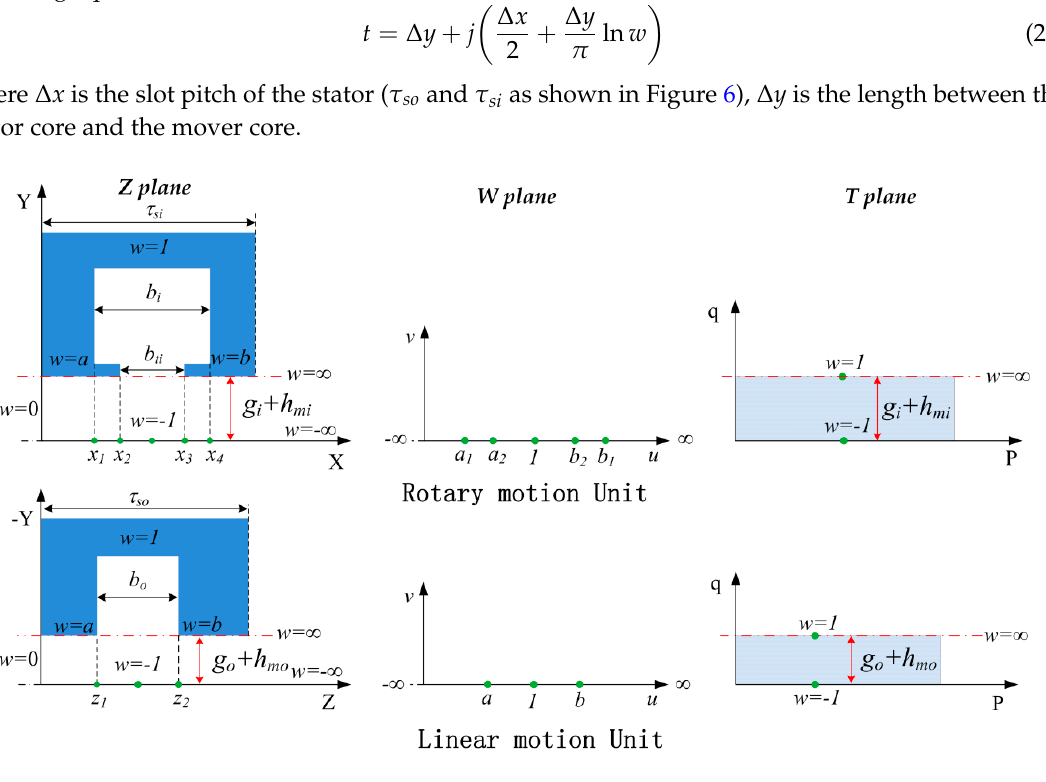
Figure 6. Slot opening in different planes.